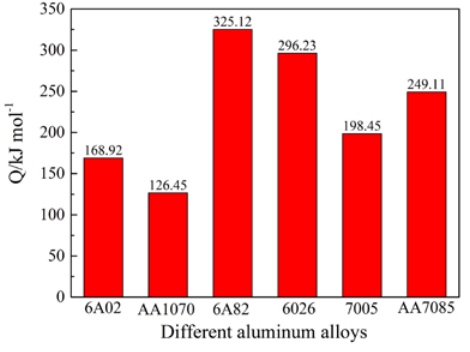
Figure 4. Relationship among stress, strain rate and temperature at a strain of 0.1: ( a ) ln ε  − ln σ ; ( b )